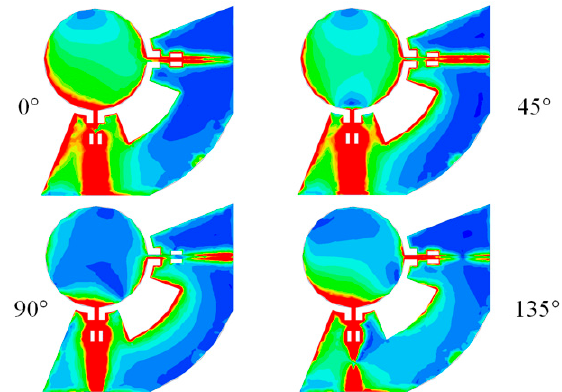
Figure 7. The simulated magnitude of current distribution on top and bottom layers at 2.4 GHz and different 0-, 45-, 90-, and 135-degree phases.